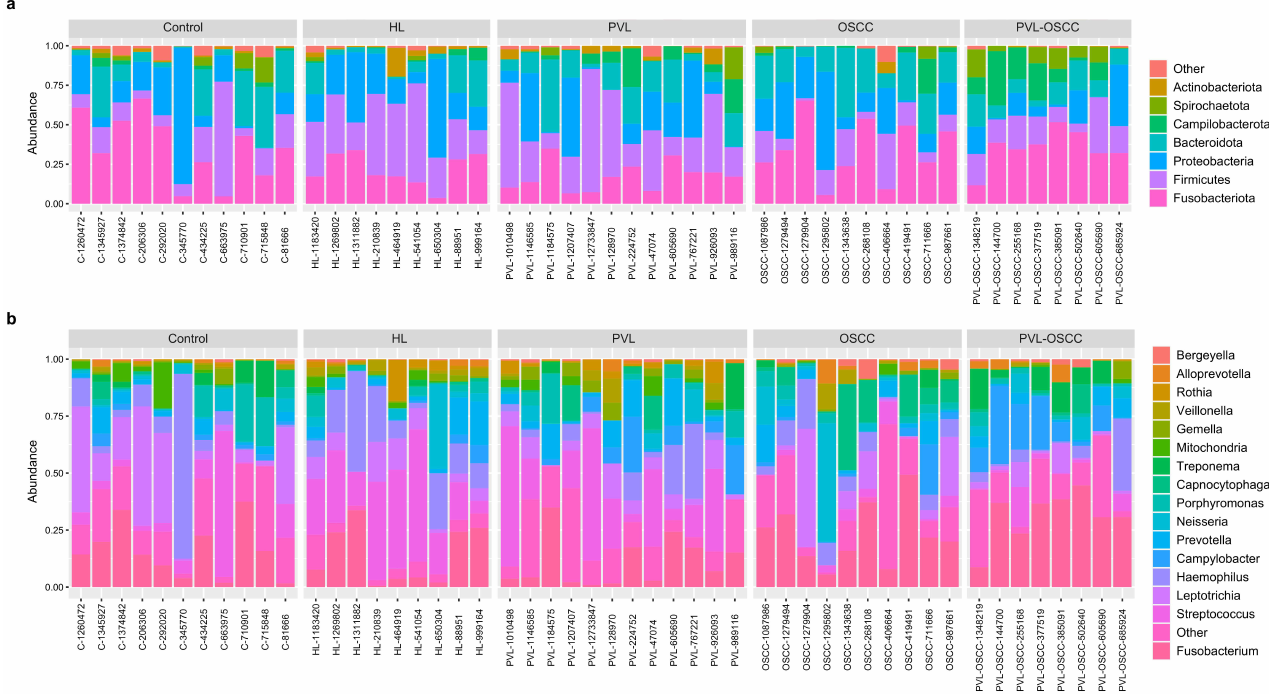
Figure 2. Stacked bar plot of the phylogenetic composition of the most common taxa at the phylum ( a ) and genus ( b )